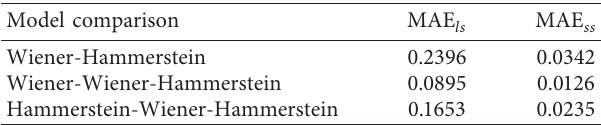
Figure 6: Responses of Wiener (blue), Hammerstein (green), and Wiener–Hammerstein (red) models when they are excited with a multistep signal (dashed) with large (a) and small (b) amplitude changes. Table 1: Model comparison calculated as MAE when they are excited with large amplitude changes ( MAE ls ) or low ones ( MAE ) . ss